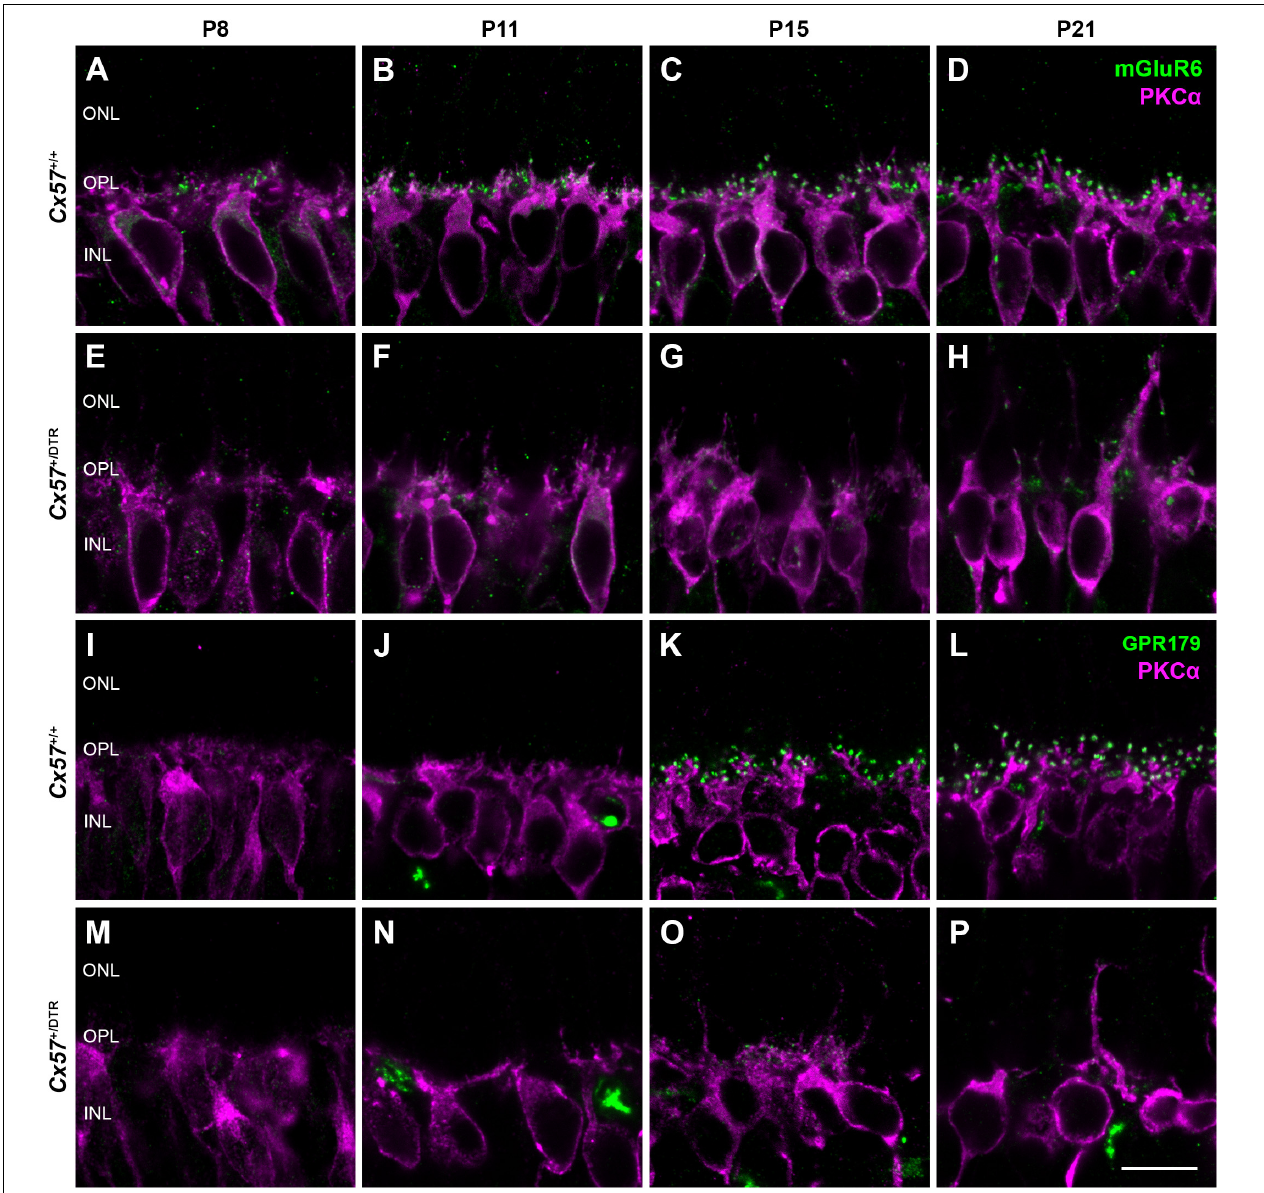
FIGURE 4 | Horizontal cell ablation affects mGluR6 and GPR179 localization in rod bipolar cells. (A–H) Vertical sections from Cx57 + / + and Cx57 + / DTR retinae were stained for mGluR6 (green) and PKC α (magenta), a rod bipolar cell marker. In control mice, rod bipolar cell processes terminated in the OPL. Expression of mGluR6 at the dendritic tips of rod bipolar cells was already detectable at P8 and increased up to P21 (A–D) . By contrast, rod bipolar cell dendrites from horizontal cell-ablated mice showed an outgrowth into the ONL and a reduced mGluR6 accumulation (E–H) . (I–P) Retinae of Cx57 + / + and Cx57 + / DTR mice were double labeled with an antibody against Ca v 1.1 (green), that cross-reacts with GPR179, and an antibody against PKC α (magenta). GPR179-immunoreactive puncta decorated the distal tips of rod bipolar cells as early as P15 in the wild-type retina (I–L) . In comparison, horizontal cell-ablated retinae displayed only very few and small GPR179-positive puncta at rod bipolar cell dendritic tips (M–P) . Scale bars, 10 µ